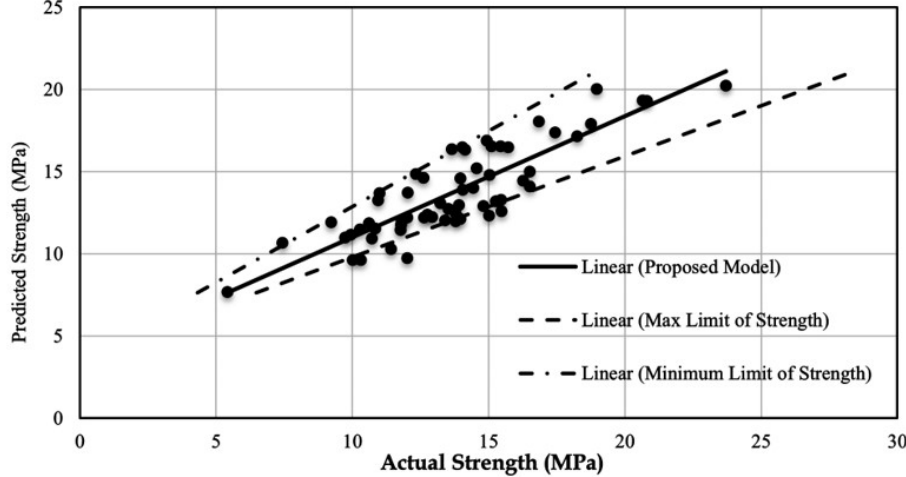
Figure 7. Actual vs. predicted compressive strength.